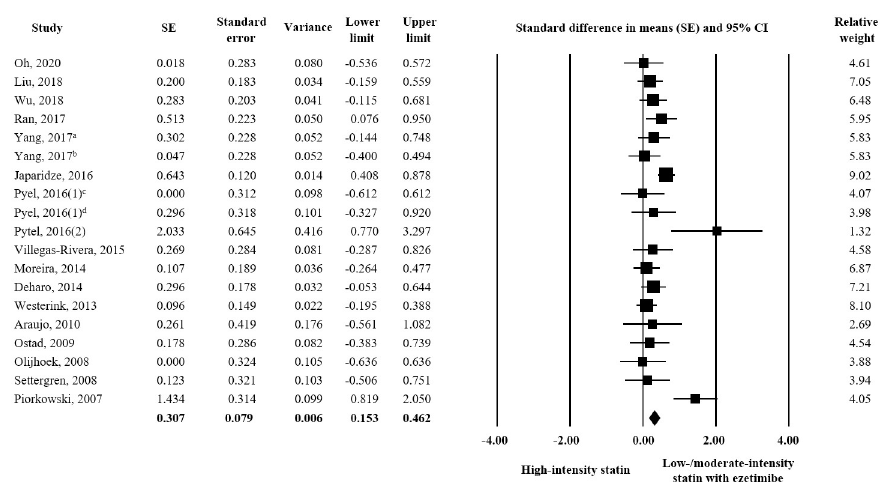
Fig 2. Forest plot of efficacy evaluation results. Changes in LDL-C observed for high-intensity statin monotherapy and low/moderate-intensity statin plus ezetimibe combination therapy. a rosuvastatin 20 mg vs. rosuvastatin 5 mg plus ezetimibe 10 mg; b rosuvastatin 20 mg vs. rosuvastatin 10 mg plus ezetimibe 10 mg; c rosuvastatin 20 mg vs. atorvastatin 10 mg plus ezetimibe 10 mg; d atorvastatin 40 mg vs. atorvastatin 10 mg plus ezetimibe 10 mg.